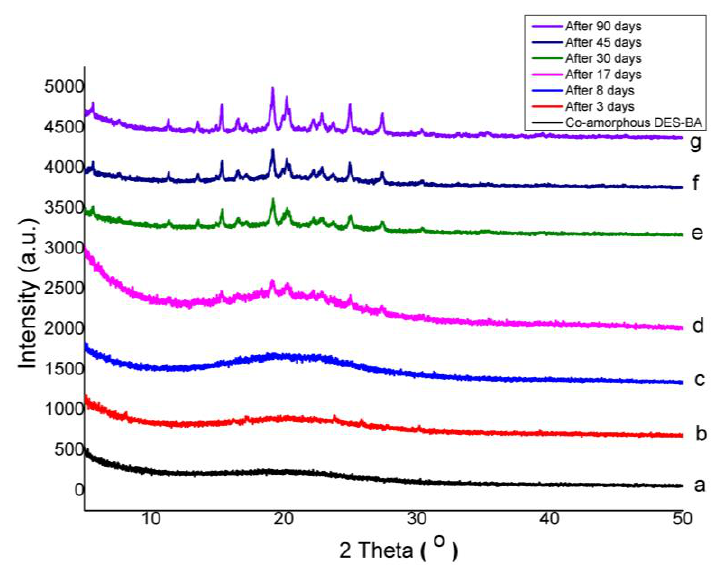
Figure 7. PXRD patterns of co-amorphous desloratadine-benzoic acid (DES–BA) system for stability studies after storing at 40 °C under 75% RH and measured after specified periods of time: fresh prepared ( a ), 3 days ( b ), 8 days ( c ), 17 days ( d ), 30 days ( e ), 45 days ( f ) and 90 days ( g ).